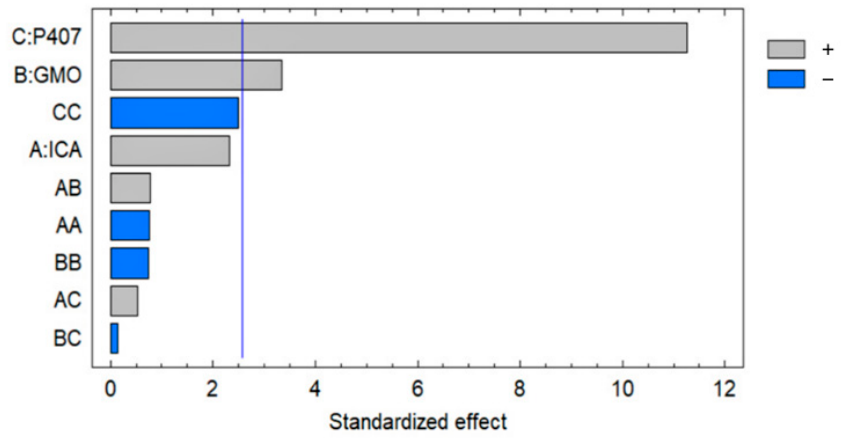
Figure 4. Pareto chart showing the effect of the ICA, GMO, and P407 concentrations on the EE of the ICA-Cubs formulation.